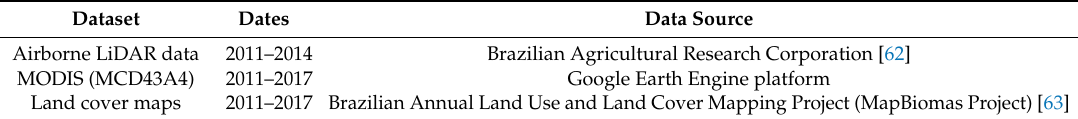
Table 1. The datasets used in this